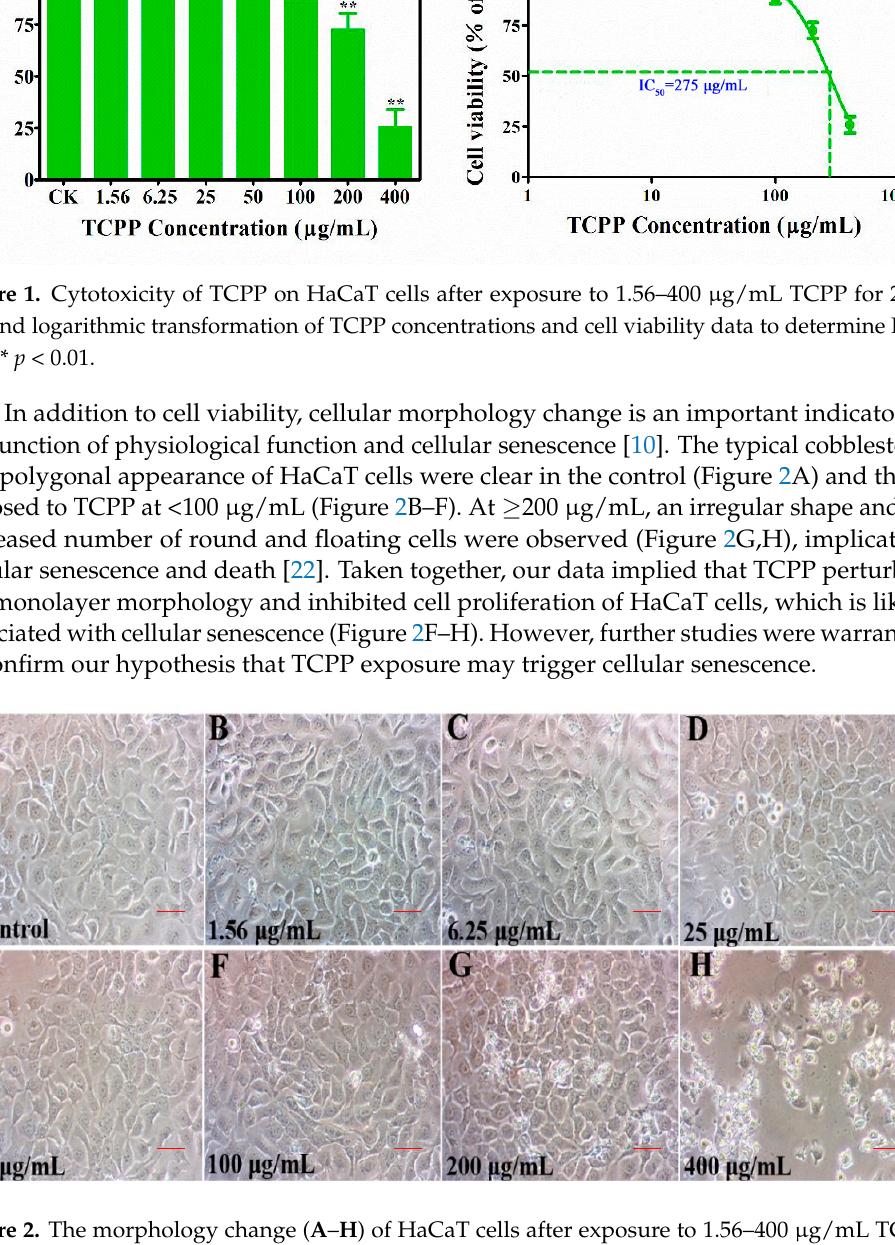
Figure 2. The morphology change ( A – H ) of HaCaT cells after exposure to 1.56–400 µ g/mL TCPP Figure 2 . The morphology change ( A – H ) of HaCaT cells after exposure to 1.56–400 μ g/mL TCPP for for 24 h. Images were recorded under an inverted phase contrast microscopy at 200 × magnification. 24 h. Images were recorded under an inverted phase contrast microscopy at 200×magnification. Scale bar 50 µ Scale bar 50 μ m.